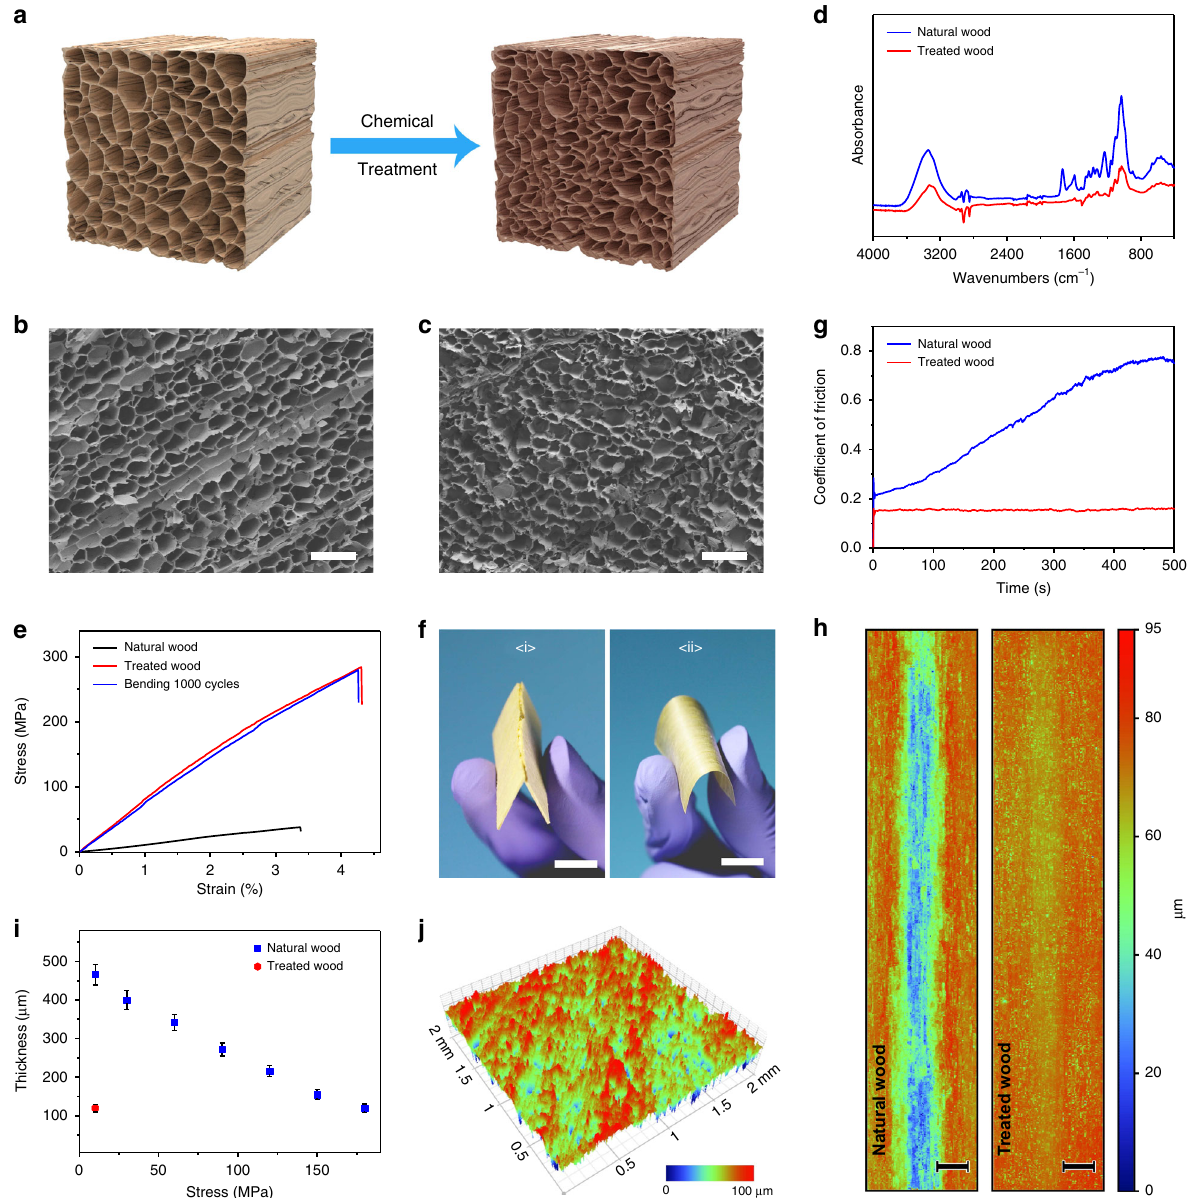
Fig. 2 Evolution of natural balsa wood upon chemical treatment and hot-pressing. a Graphical illustration of the structural evolution of natural wood upon chemical treatment. b , c Cross-sectional SEM images of the natural wood and treated wood. Scale bar, 100 μ m. d FTIR spectra of the natural wood and treated wood. e Tensile stress-strain curves of the natural wood and treated wood (before and after bending 1000 cycles). f Comparison of fl exibility between natural wood and treated wood. (i) Natural wood fi lm breaks upon bending. (ii) Treated wood shows high fl exibility upon bending. Scale bar, 1 cm. g Coef fi cient of friction evolution of natural wood and treated wood. h Interferometer images of wear traces on natural wood and treated wood after 5000 cycles of rubbing, showing notable decrease of wear depth of the treated wood. Scale bar, 500 μ m. i Compression thickness of the natural wood and treated wood after hot-pressing. Error bars indicate standard deviations for 5 sets of data points. j Interferometer image showing the surface topography